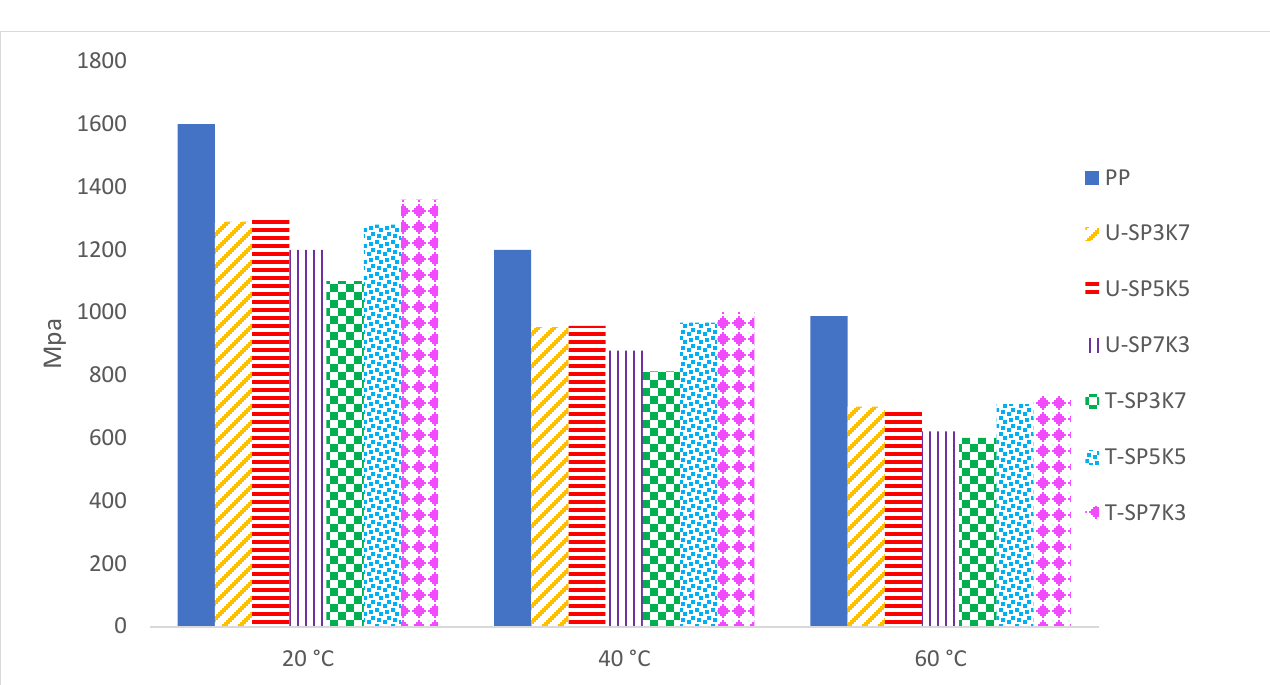
Figure 5. Temperature dependence of the storage moduli (E’) MPa of varied compositions SPF/KF/PP hybrid composite at 20, 40 and 60 °C.